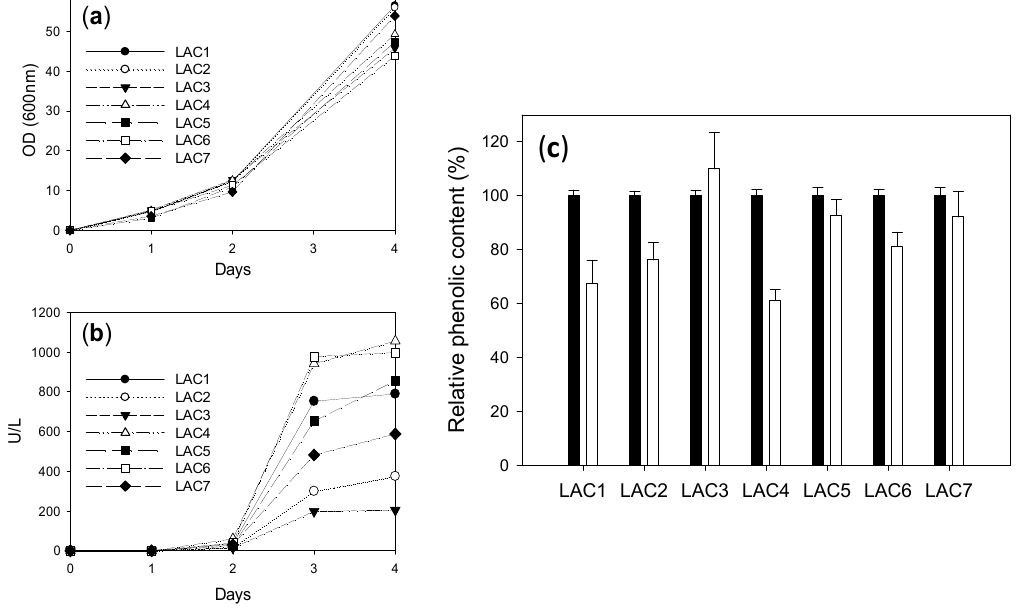
Figure 3. Optical density (OD) at 600 nm ( a ) and laccase activity (with 3 mM ABTS pH 5) ( b ) in S. cerevisiae cultures producing selected laccase variants (flasks). Relative phenolic content in DP401 lignosulfonate before (black bars) and after 24 h treatment with concentrated crudes of these laccases (20 mU/mL) (white bars). Error bars indicate standard deviation for three replicates ( c ).